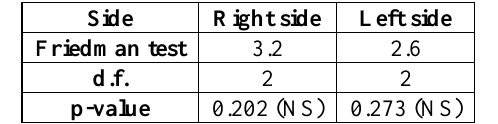
Table 2: Effect of time on the bacterial count for both